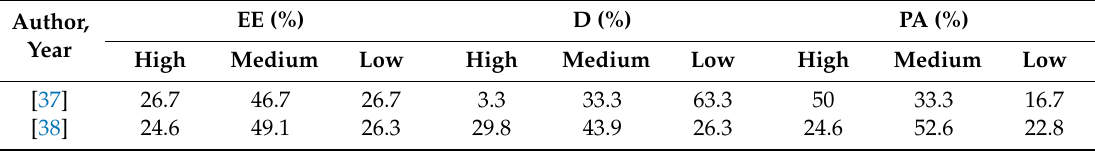
Table 2. Distribution of the three Maslach burnout inventory (MBI) components and their respective